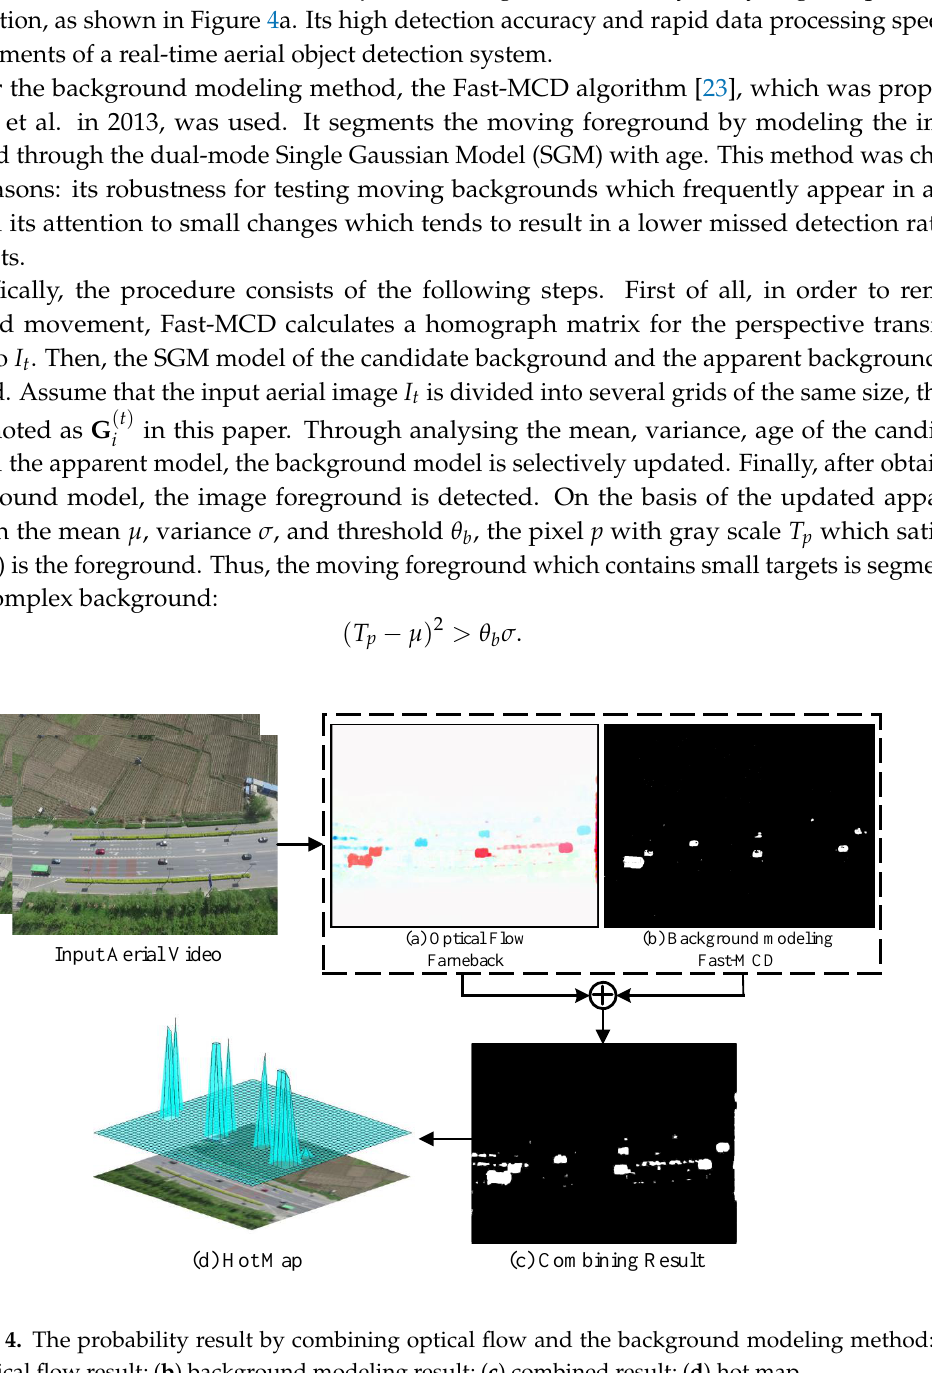
Figure 4. The probability result by combining optical flow and the background modeling method: ( a ) optical flow result; ( b ) background modeling result; ( c ) combined result; ( d ) hot